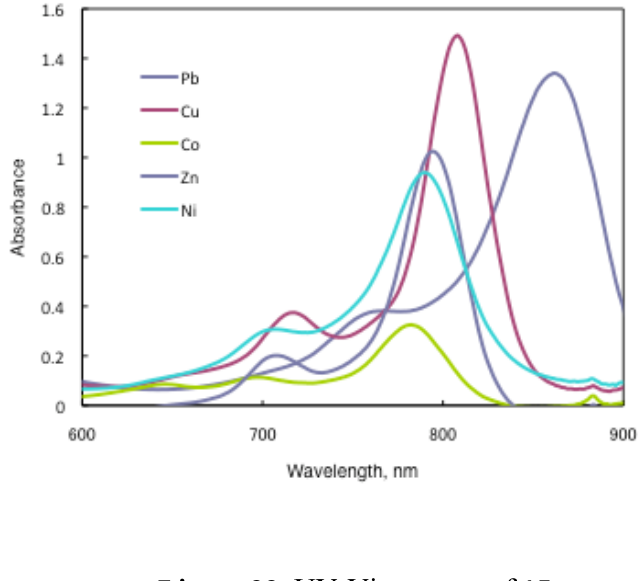
Figure 22 . UV-Vis spectra of 15c